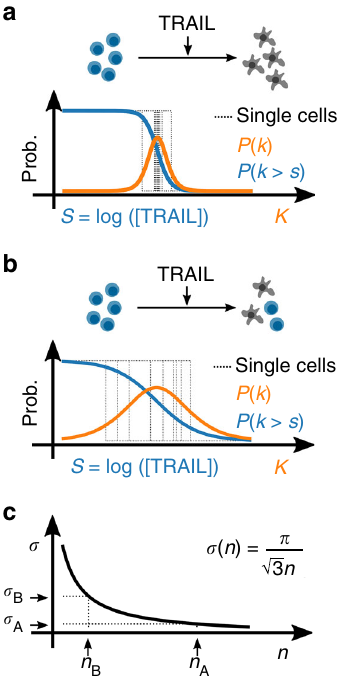
Fig. 2 Cell-to-cell variability in the binary response to TRAIL. Hill response function with respect to TRAIL dose (blue) and the corresponding probability density of the single-cell sensitivities (orange) for populations with a low CCV and b high CCV. c The theoretical correspondence between the variance of single-cell sensitivities to TRAIL ( σ ) and the Hill coef fi cient n . Here, ( n σ n σ fi cient and A , A ) and ( B , B ) represent the Hill coef corresponding single-cell variances from a and b ,